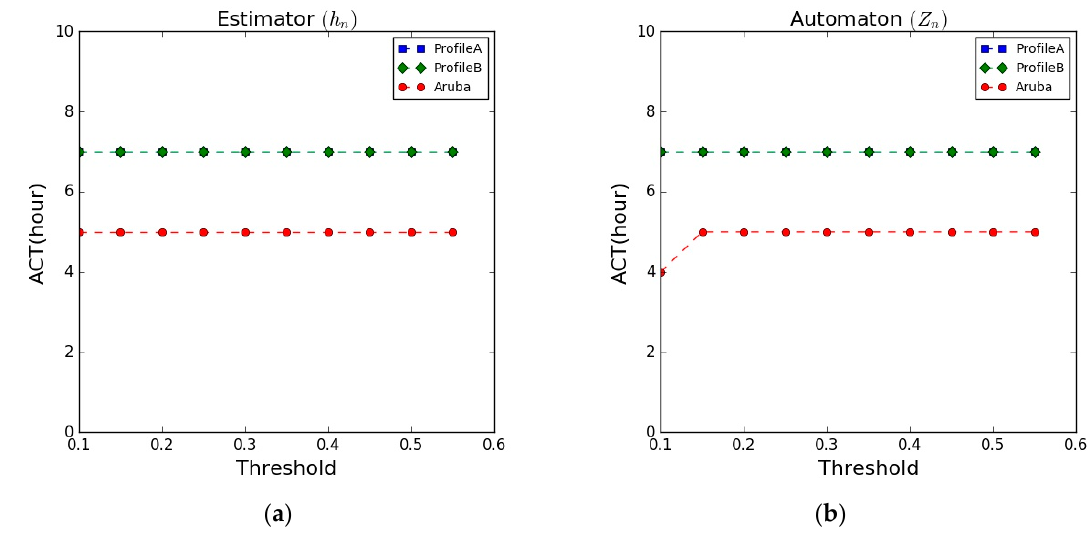
Figure 10. Anomaly Confirmation Time (ACT). ( a ) Estimator results; ( b ) Automaton results.